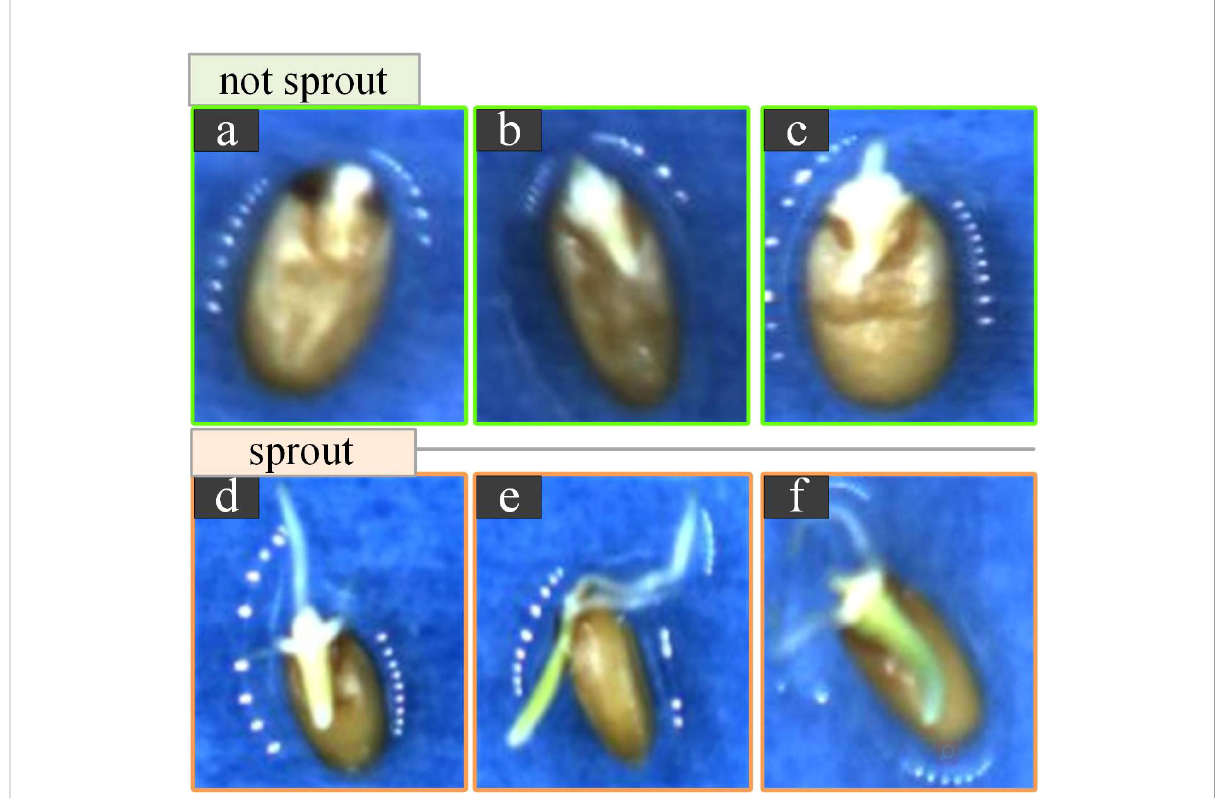
FIGURE 3 Schematic diagrams of germinated and ungerminated wheat seeds. (A-C) . Examples of ungerminated seeds. (A) Seeds are dewy with no germ radicle. (B) . There is a germ without a radicle. (C) . There is a germ radicle, however, it does not reach half of its length. (D-F) . Examples of germinated seeds. (D) Seeds have a radicle and the radicle has three distinct roots and it reaches half of its length. (E) . Seeds are lying on their sides. (F) . The radicle has taken on a green colour and is growing upward growth